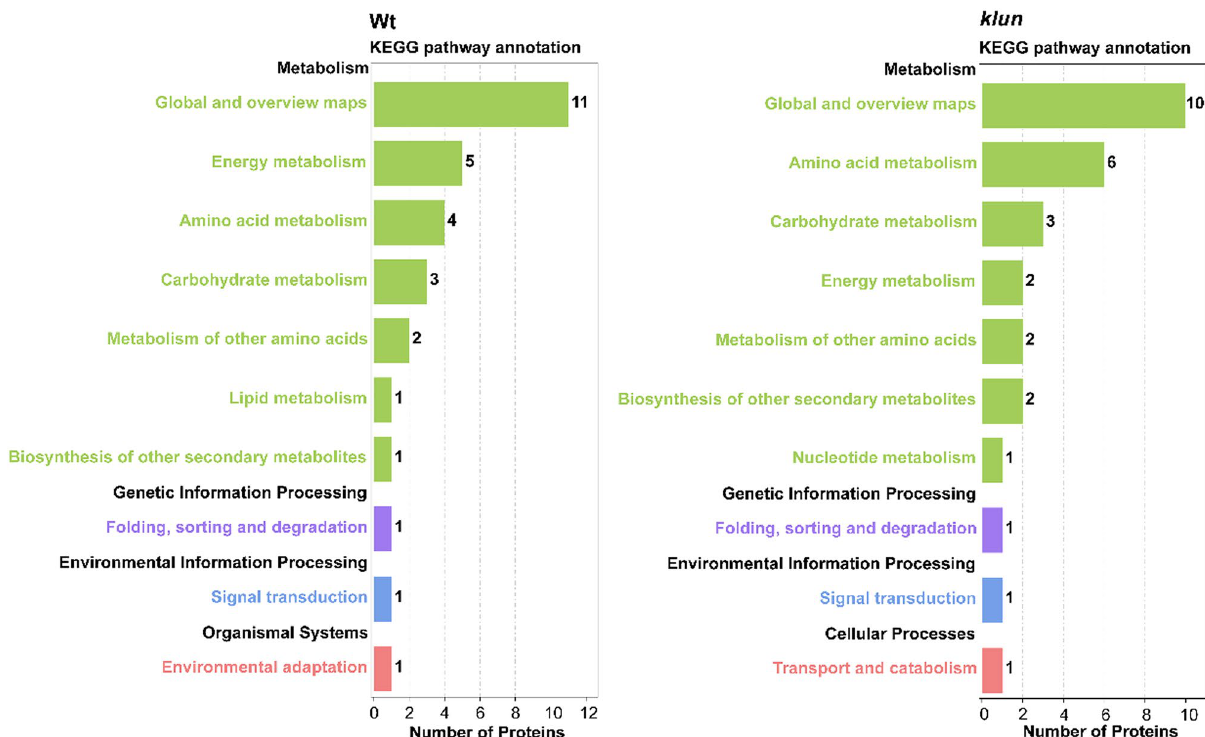
Figure 7. KEGG pathway enrichment analysis of 14-3-3 potential target proteins changed upon Fe deficiency in Wt and klun roots. The left y-axis indicates the KEGG’s A-level and B-level categories. The black font is the A-level category name, and the color font is the B-level category name; x-axis indicates the number of proteins in the corresponding B-level classification. See also Table S7 & S8 showing the KEGG enrichment analysis of the identified proteins. KEGG pathway annotation was obtained from the KEGG pathway database (http:// www. genome. jp/ kegg/ pathw